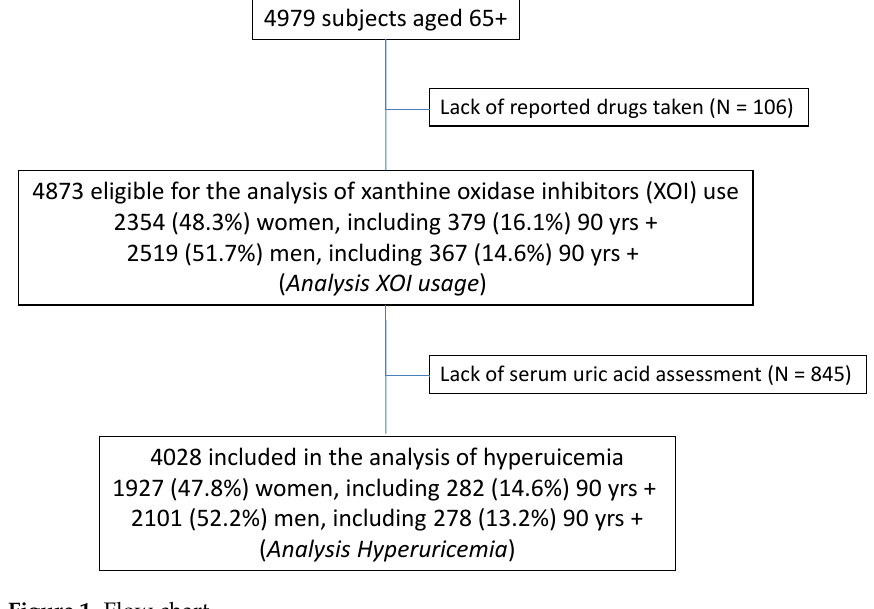
Figure 1. Flow chart.